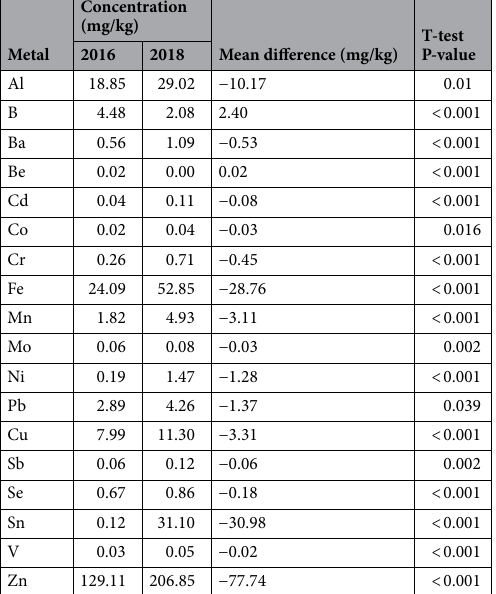
Table 2. Comparison of the mean concentrations of heavy metals detected in hair root samples collected in 2016 and 2018 from the same individuals living in Paragsha. Al aluminium, B boron, Ba barium, Be beryllium, Cd cadmium, Co cobalt, Cr chromium, Fe iron, Mn magnesium, Mo molybdenum, Ni nickel, Pb lead, Cu copper, Sb antimony, Se selenium, Sn tin, V vanadium, Zn